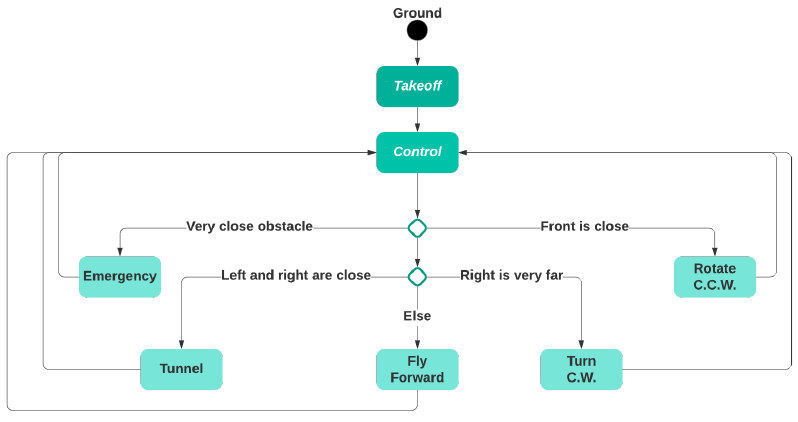
Figure 3. BAT’s controlling state machine.